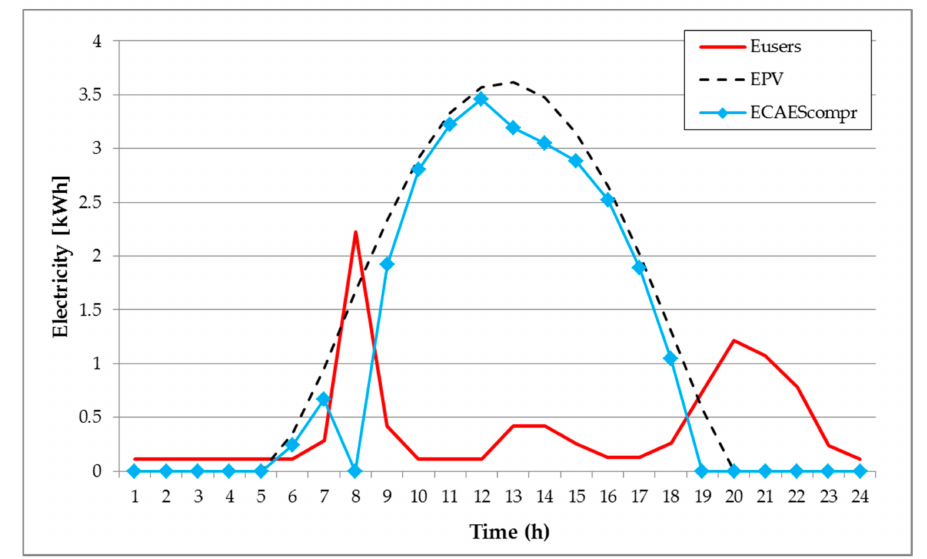
Figure 7. Daily profile: energy consumption; energy produced by PV; energy available for air